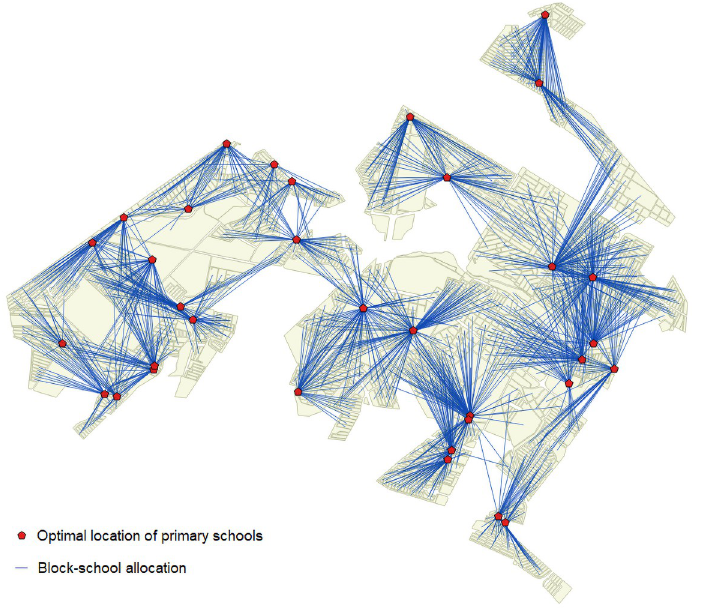
Fig 9. Block-school